Question: Write a descriptive caption for this figure.
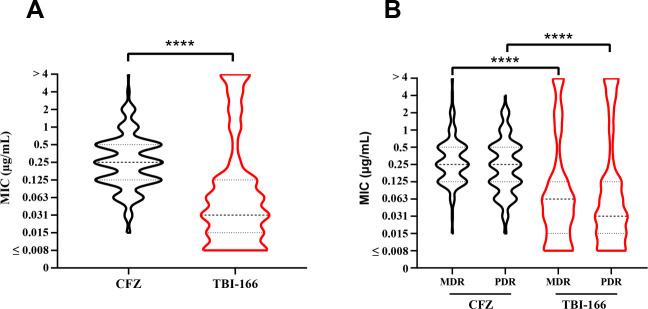
Answer: MIC distributions of CFZ and TBI-166 against MTB. ( A ) In vitro antibacterial activity of CFZ and TBI-166 against all DR-TB isolates; ( B ) MIC distributions stratified by MDR-TB and pre-XDR-TB subgroups. Data are presented as violin plots, where the width of each violin represents the kernel probability density of the MIC data (wider sections indicate a higher density of isolates at that MIC value). Different colored plots denote specific drugs: black for CFZ and red for TBI-166. Statistical differences were analyzed using nonparametric tests, followed by Dunnett’s multiple comparison test. **** P < 0.0001. MIC, minimum inhibitory concentration; MDR, multidrug-resistant Mycobacterium tuberculosis ; PDR, pre-extensively resistant Mycobacterium tuberculosis .